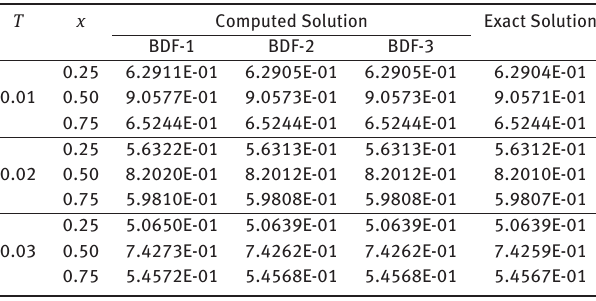
Table 4: Numerical solutions obtained by proposed schemes and the exact solutions for Example 1: ν = 1 , Δx = 0.0125 and Δt = 0.0001 .